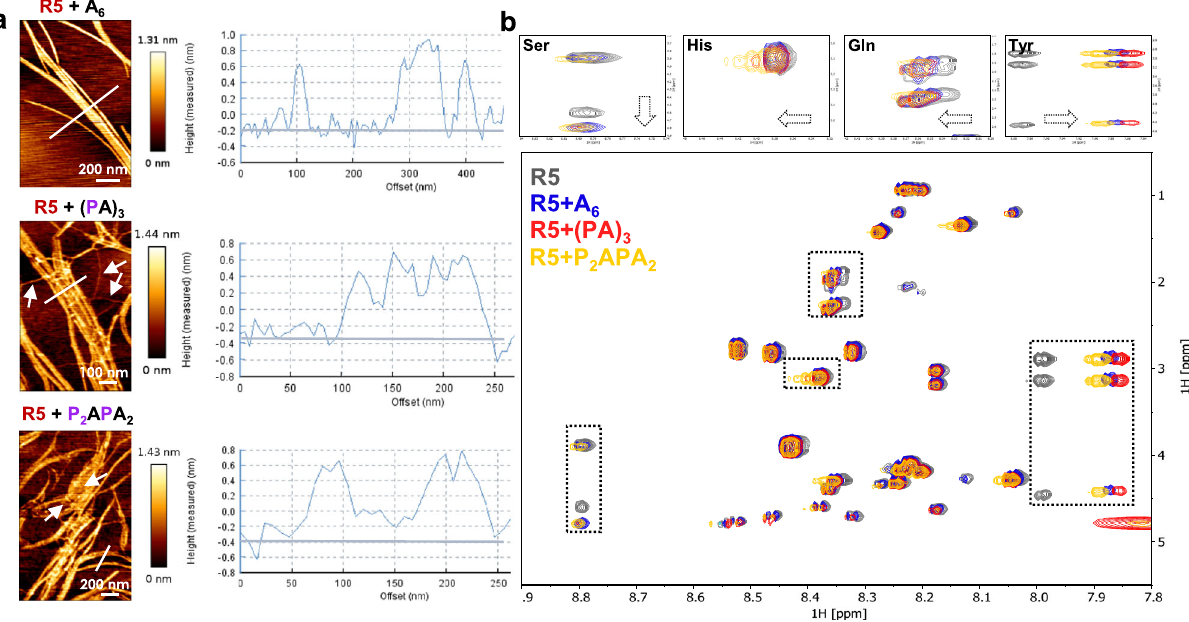
Fig. 3 Structural analysis of the fi bers generated from the assembly of R5 in the presence of three different oligosaccharides. a AFM images of the fi bers at Day 1. The average fi ber height is around 0.8 nm for all three samples. The enmeshed matrices are highlighted with white arrows. b Overlay of a selected region of the 1 H- 1 H TOCSY spectra for the samples containing R5 alone (gray) and in the presence of A 6 (blue), (PA) 3 (red) and P 2 APA 2 (yellow). Each spectrum was recorded with a R5 concentration of 200 µ M in H 2 O/D 2 O (9:1) at 25 °C. The four amide protons mostly affected by the presence of the oligosaccharides are highlighted (top panels), showing a change in chemical shift (His, Gln, Tyr) or signal broadening (Ser).